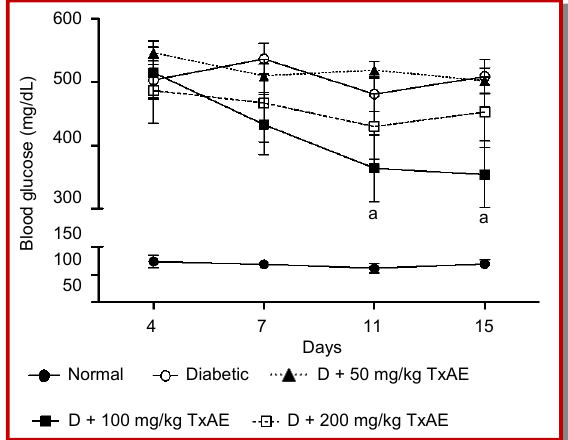
Figure 1: Effect of T. angustifolia aqueous extract administra- tion blood glucose levels (mg/dL) of alloxan-induced diabet- ic mice (data are mean ± SE; n=7 mice/group). a p<0.05 as compared with the diabetic group. D: Diabetic; TxAE: T.